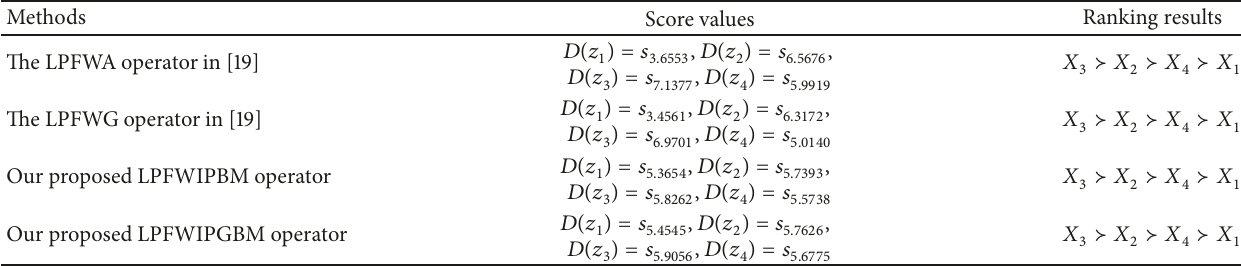
Table 7: The ranking results of our proposed operators and the operators in [19].